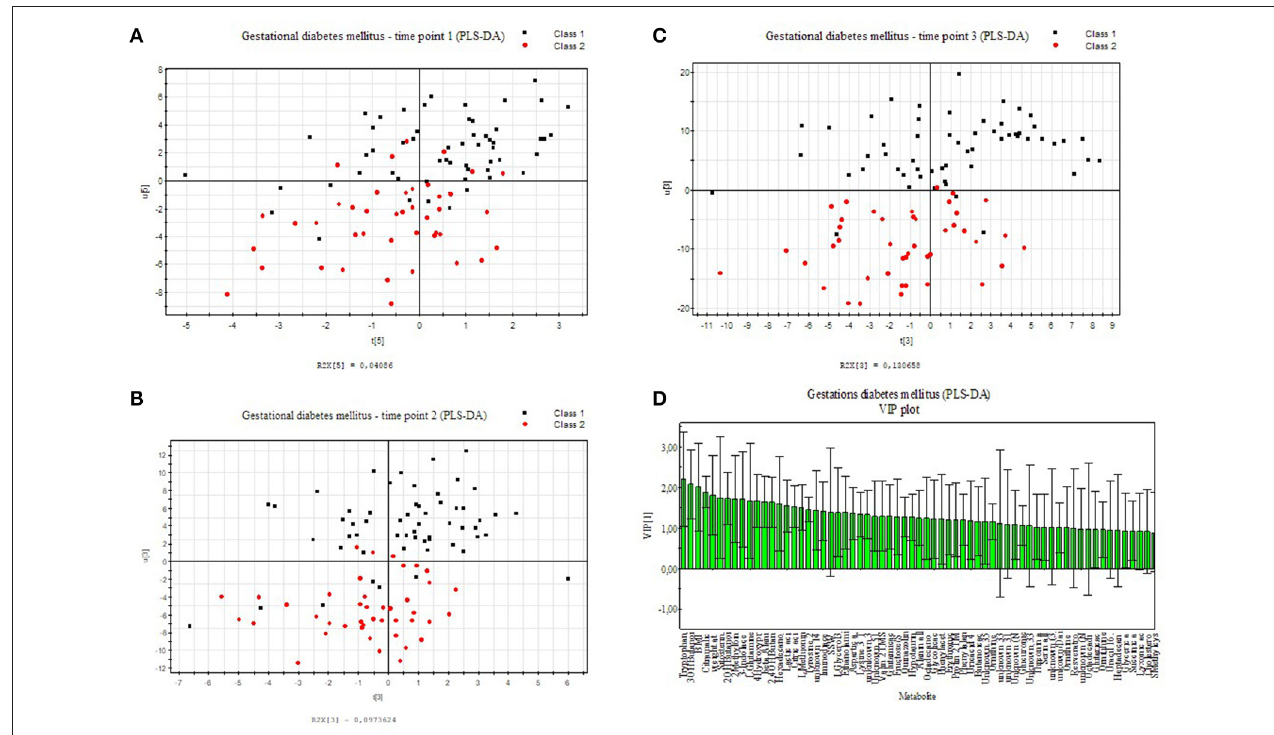
FIGURE 1 | PLS-DA model built for two classes, control and GDM for three different time points of the oral glucose tolerance test (oGTT). Healthy pregnant women are labeled by black squares (class 1) and GDM individuals are labeled with red dots (class 2). (A) 0h, (B) 1h, (C) 2h (D) VIP projection of the variables according to the scores plot of B